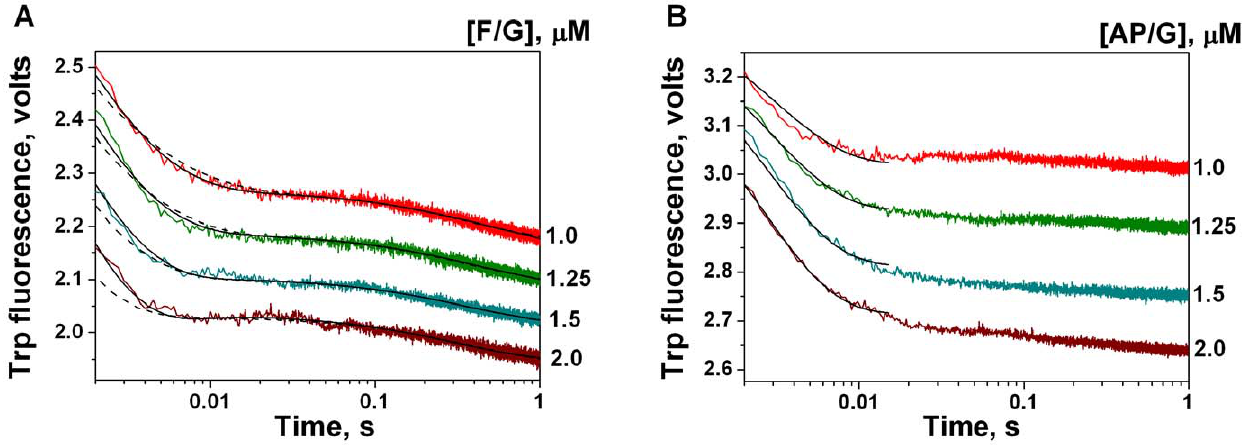
Figure 4. Trp fluorescence traces of APE1K98A (1 m M) interacting with substrates F/G (A) and AP/G (B). The reactions were carried out in BER buffer. Smooth curves are the result of the fitting procedure. Traces were fitted to kinetic schemes containing a single (A, dashed curves) or a double (A, B, solid curves) binding equilibrium. Concentrations of the substrates are indicated next to the right axis.